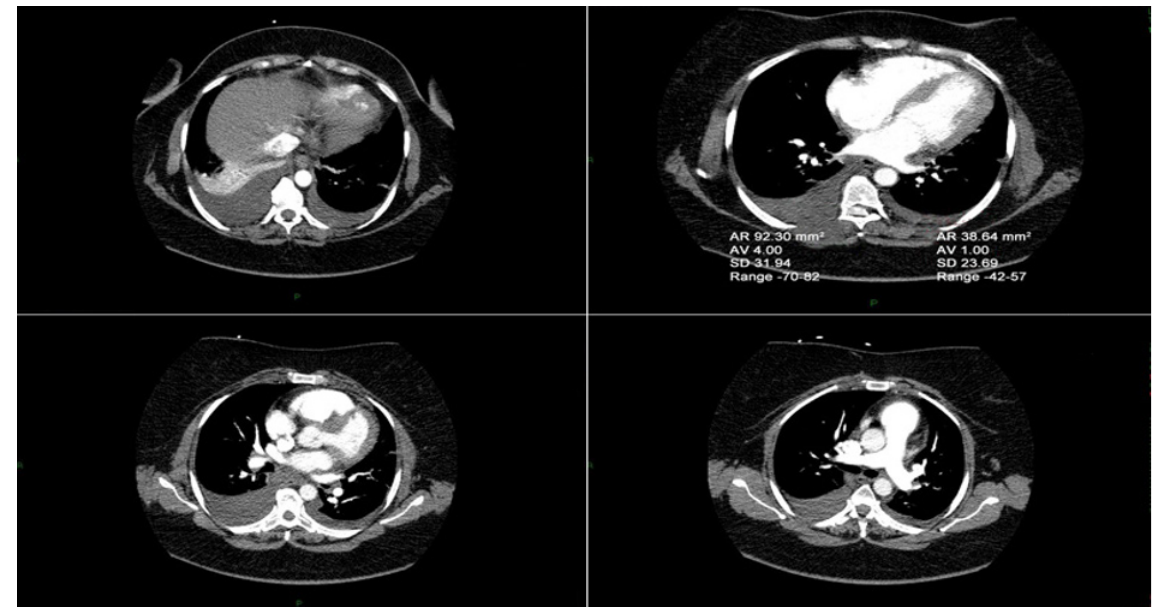
Figure 3. CT angiography showing bilateral pleural effusions - small on the left side and moderate on the